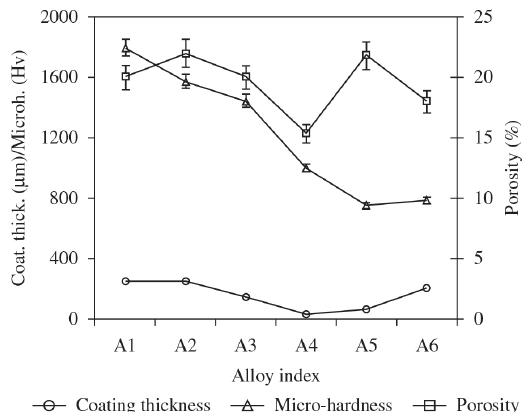
Figure 1. Experimental values of PEO-induced oxide layer thickness (exaggerated by a factor of two for clarity), porosity and micro-hardness for each of the alloys